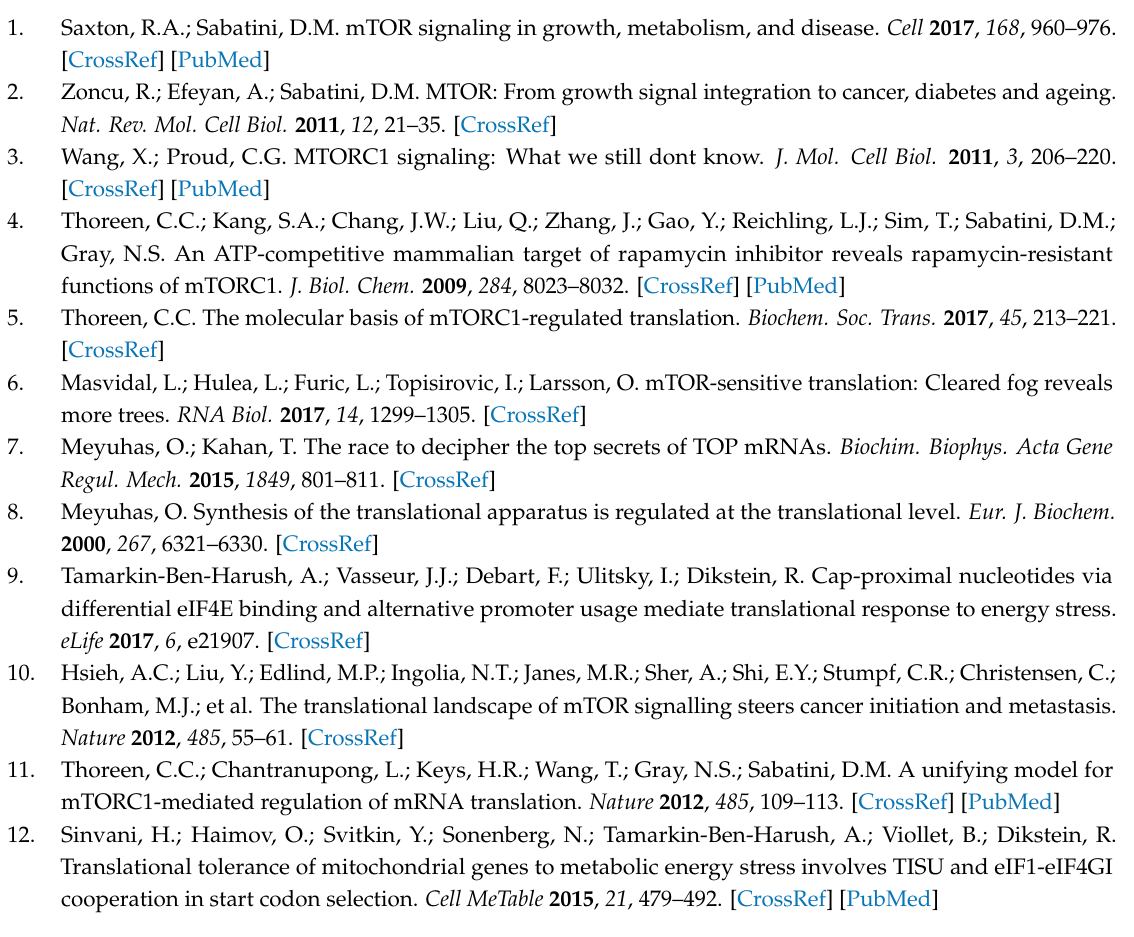
Figure S1: Polysome profiles of HEK293T cells, Table S1: Primers for promoter cloning, qPCR and 5’